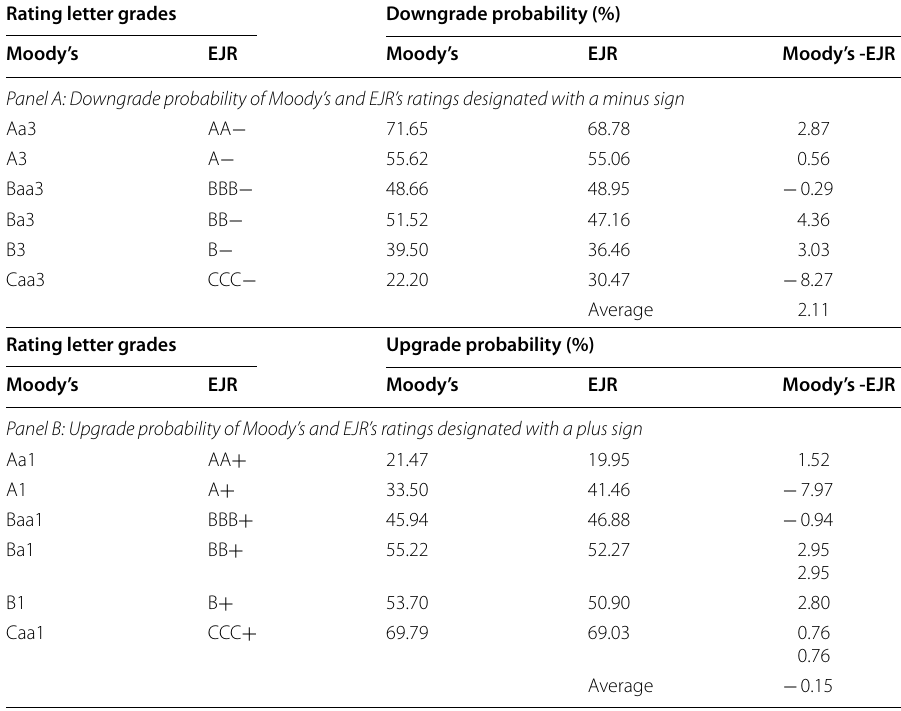
Table 4 Probabilities of rating changes in threshold ratings Rating letter grades Downgrade probability